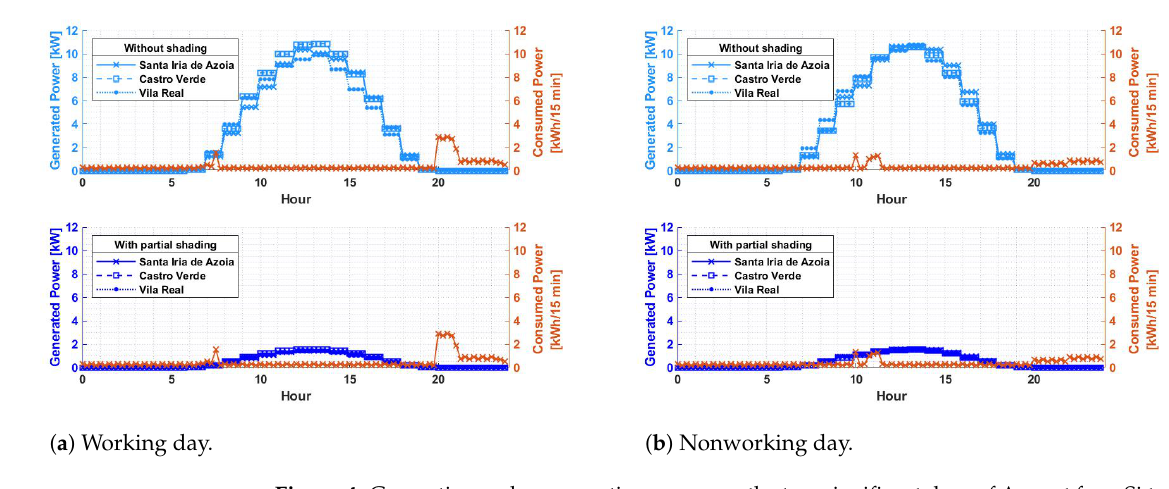
Figure 4. Generation and consumption curves on the two significant days of August for c-Si technology.